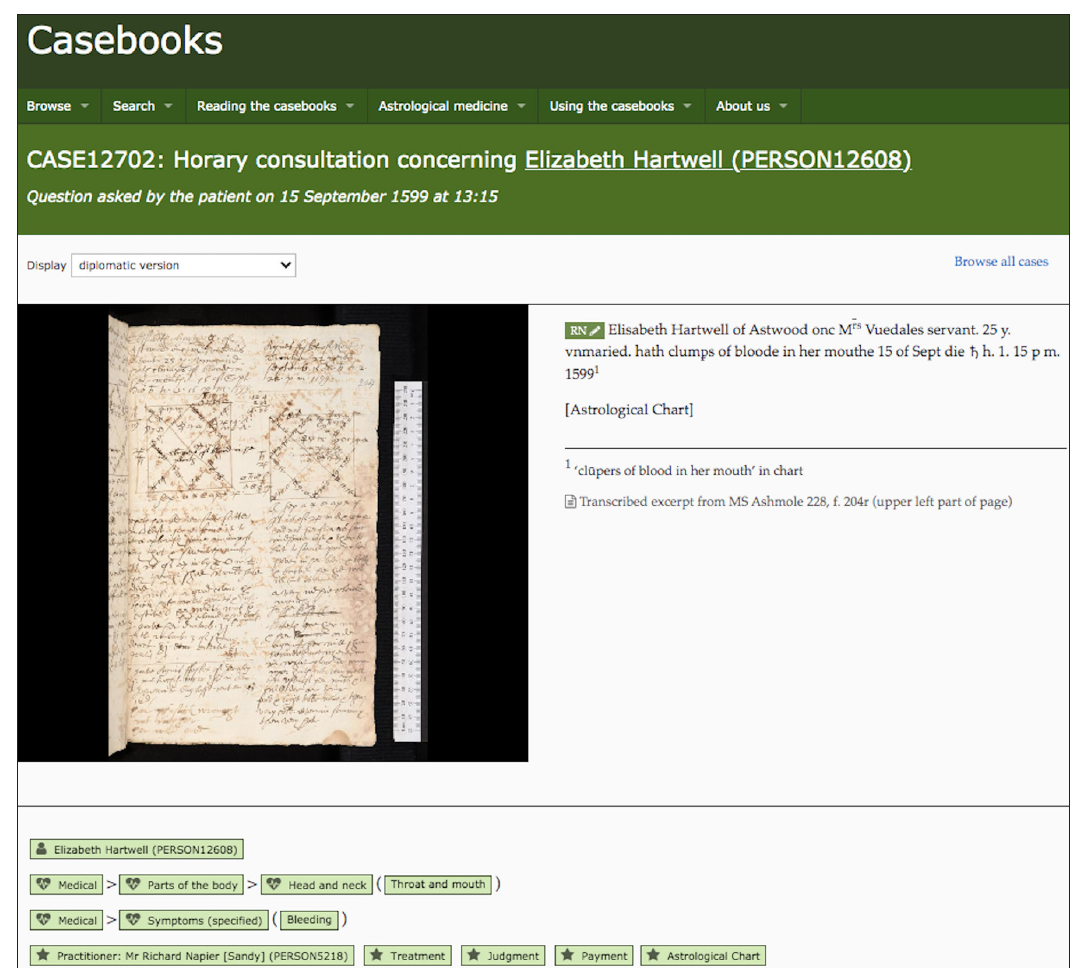
Figure 5: CASE12702 from Lauren Kassell, Michael Hawkins, Robert Ralley, John Young, Joanne Edge, Janet Yvonne Martin-Portugues, and Natalie Kaoukji, eds., “CASE12702,” The Casebooks of Simon Forman and Richard Napier, 1596–1634: A Digital Edition ,